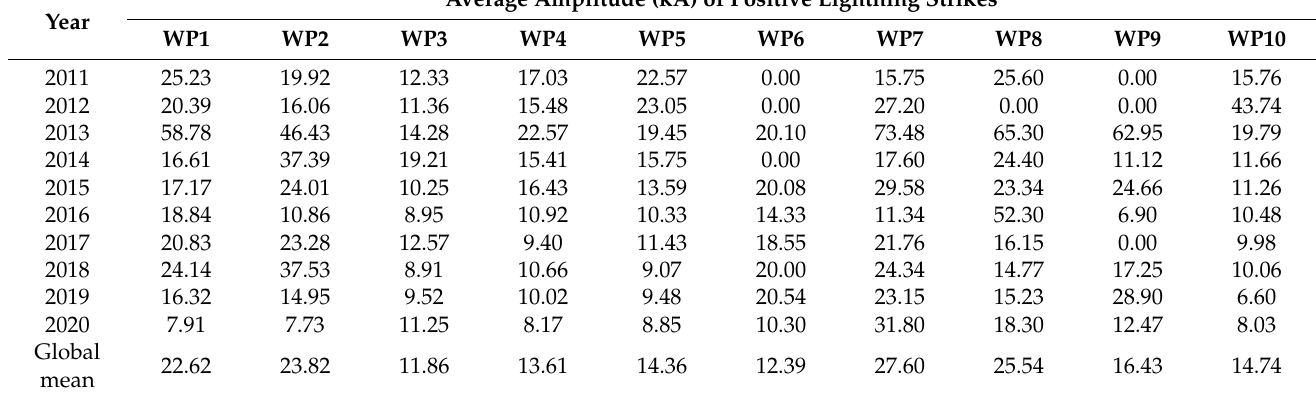
Table 6. Annual average amplitude (kA) of the recorded positive lightning strikes per wind park (observation period 2011–2020).